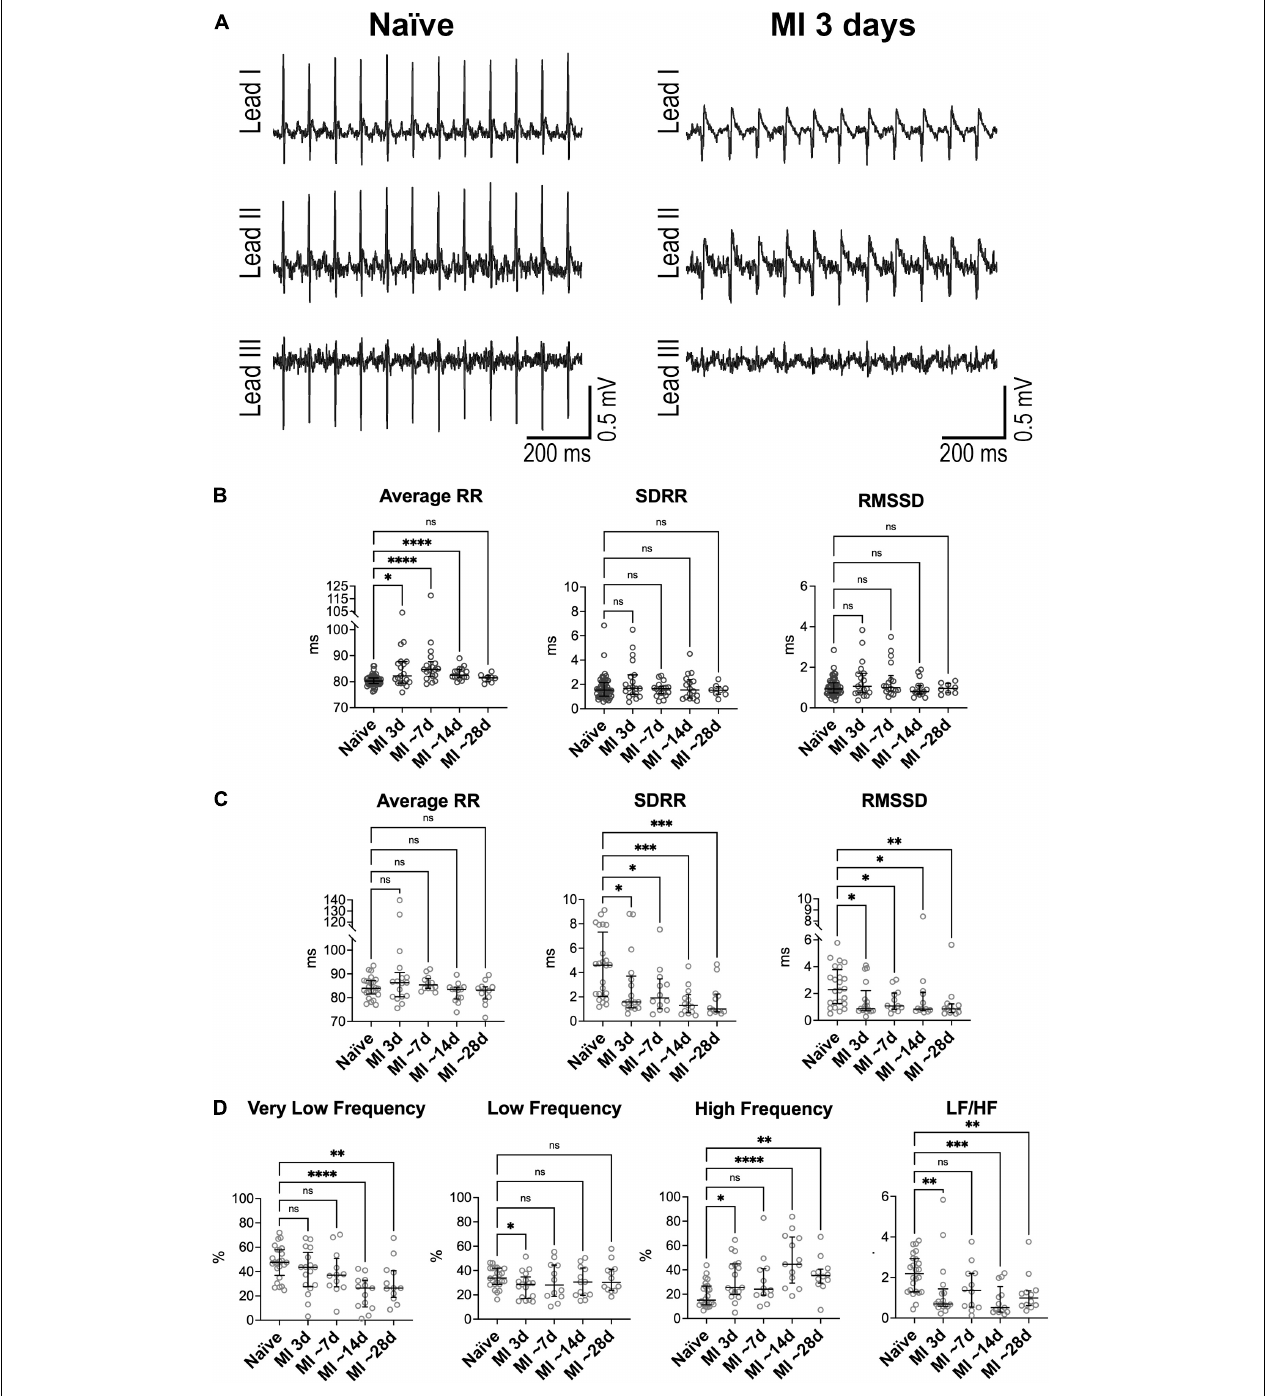
FIGURE 3 | Heart rate dynamics in mice following myocardial infarction in Homo and Het mice. (A) ECGs obtained from a Homo mouse before (Naïve) and at 3 days after myocardial infarction (MI). (B) Quantitative data for average RR interval duration and time-domain parameters of HRV in Homo naïve male and female mice ( n = 53) and Homo male and female mice at 3 ( n = 19), 7–9 ( ∼ 7, n = 18), 13–15 ( ∼ 14, n = 16), and 28 ( ∼ 28, n = 8) days after MI. (C,D) Quantitative data for average RR interval duration, time-domain parameters (C) and frequency-domain indices (D) of HRV in Het naïve male and female mice ( n = 24) and Het male and female mice at 3 ( n = 17), 7–8 ( ∼ 7, n = 12), 13–15 ( ∼ 14, n = 13), and 29–33 ( ∼ 28, n = 12) days after MI. Data are shown as scattered plots with median and interquartile ranges. ns, not significant, ∗ P < 0.05, ∗∗ P < 0.01, ∗∗∗ P < 0.001, ∗∗∗∗ P < 0.0001 using unpaired t -test or Mann-Whitney test.